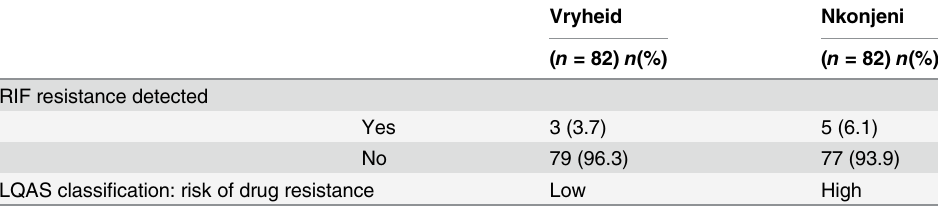
Table 2. LQAS classifications: prospective sites (n =